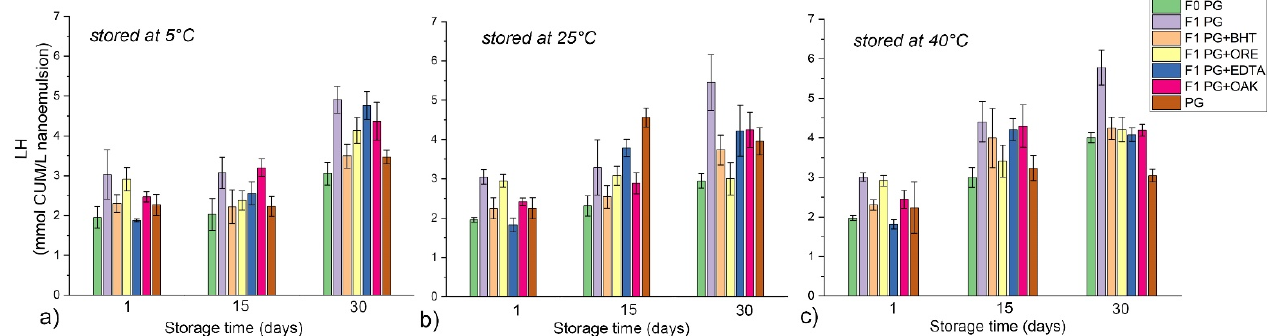
Figure 7. Lipid hydroperoxides—LH of polyglycerol ester-based mixture in water (PG) and PG-stabilized NEs during one month of storage at different temperatures: ( a ) 5 °C, ( b ) 25 °C, and ( c ) 40